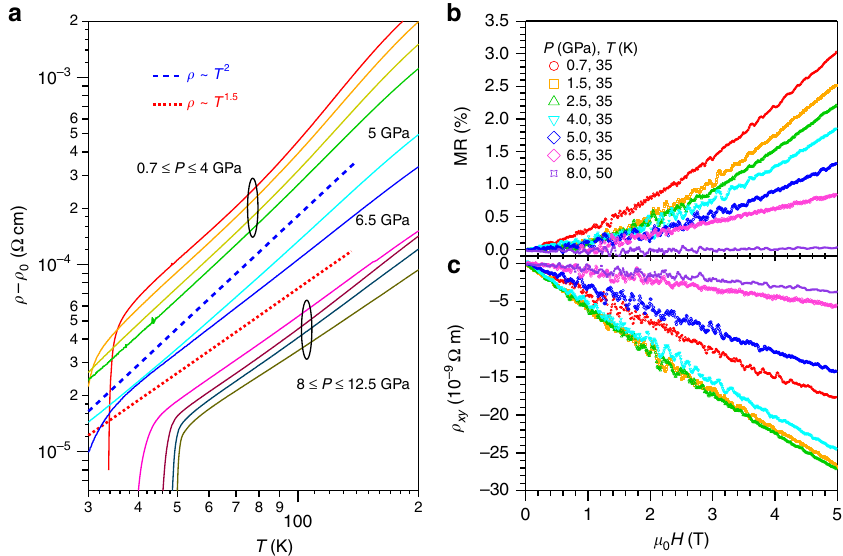
Fig. 3 Normal-state transport properties of (Li 1 − x Fe x )OHFe 1 − y Se under high pressure. a A double-logarithmic plot of ( ρ − ρ 0 ) vs. T illustrating the variation with pressure of the normal-state resistivity from the Fermi-liquid ρ ~ T 2 for P < 5 GPa to non-Fermi-liquid ρ ~ T 1.5 behavior for P > 6.5 GPa. Except for the curve at 5 GPa, all other curves have been vertically shifted for clarity. Field dependence of b the magnetoresistance MR and c the transverse resistivity ρ xy at the normal state just above T c under various pressures. The Hall coef fi cient R H is determined from the fi eld derivative of ρ xy , R H ≡ d ρ xy /d H , at each